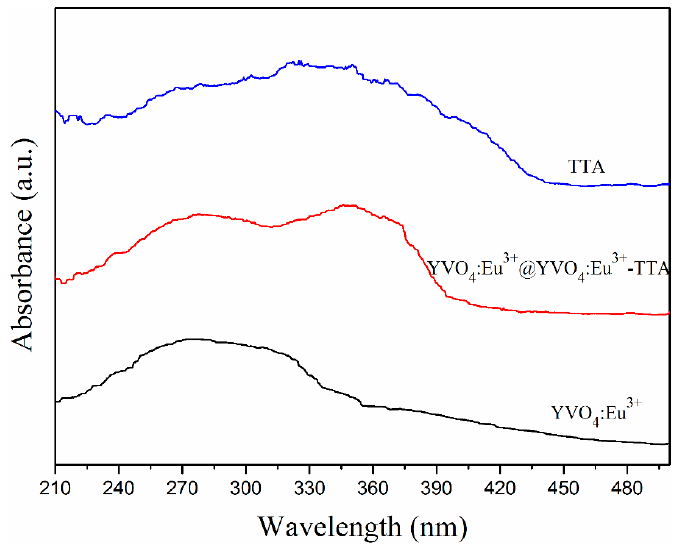
Figure 5. UV-Vis absorption spectra of the annealed YVO 4 :Eu 3 + nanoparticles, TTA and YVO 4 :Eu 3 + @ YVO 4 :Eu 3 + –TTA hybrid nanoparticles.